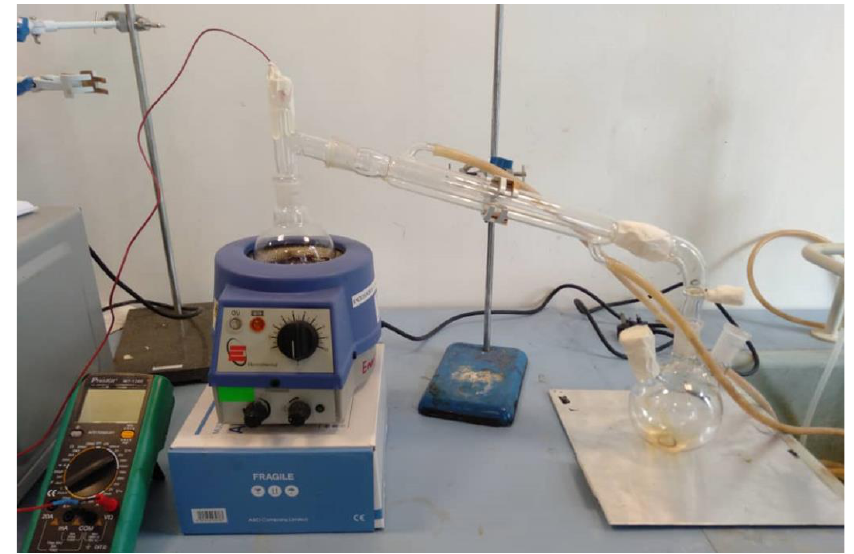
Figure 2(b): Experimental set-up of conventional heating hydrothermal liquefaction